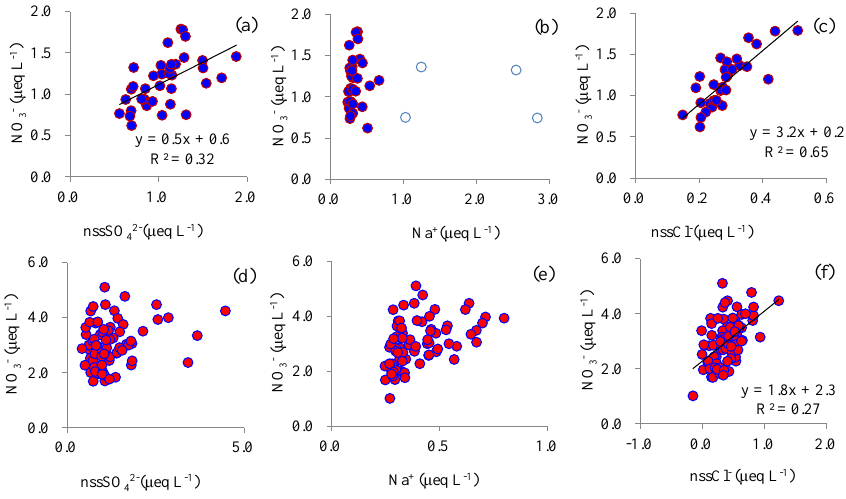
Figure 7. Relationships between NO − and co-existingmajor ions in surface snow in coastal (top row, a , b and c ) and inland (bottom row, 3 d , e and f ) Antarctica. Least-squares regressions are noted with solid line and are significant at p< 0 . 01. The four samples with high Na + concentrations are denoted by blue open circles (b) , the same as those in Fig. 8 (the blue open circles). Note that the four samples were excluded in the plot of NO − vs. nssCl − (c) 3